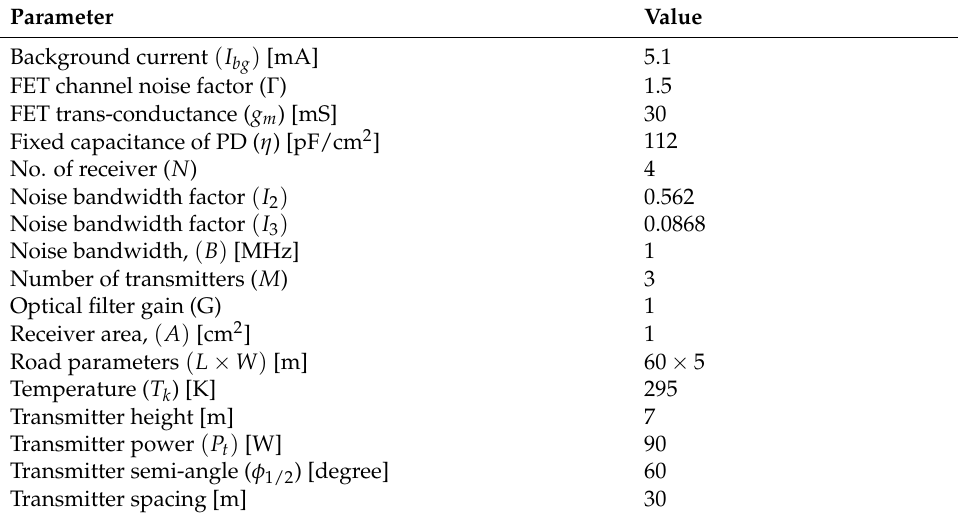
Figure 1. Schematic of VLP using streetlight. Schematic of spatial and angular diversity receiver. Table 1. Parameters used for simulation